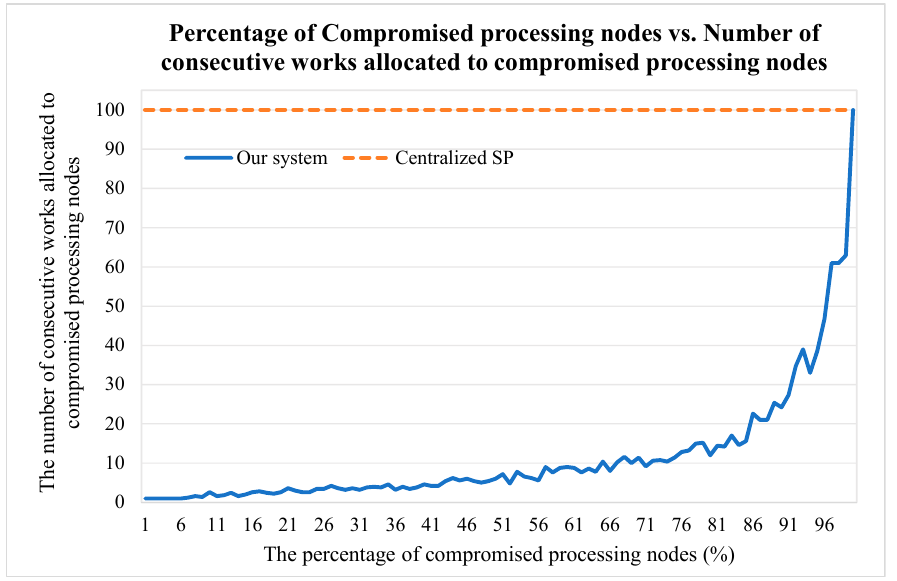
Figure 11. Compromised processing nodes vs. number of consecutive works allocated to compromised processing nodes.